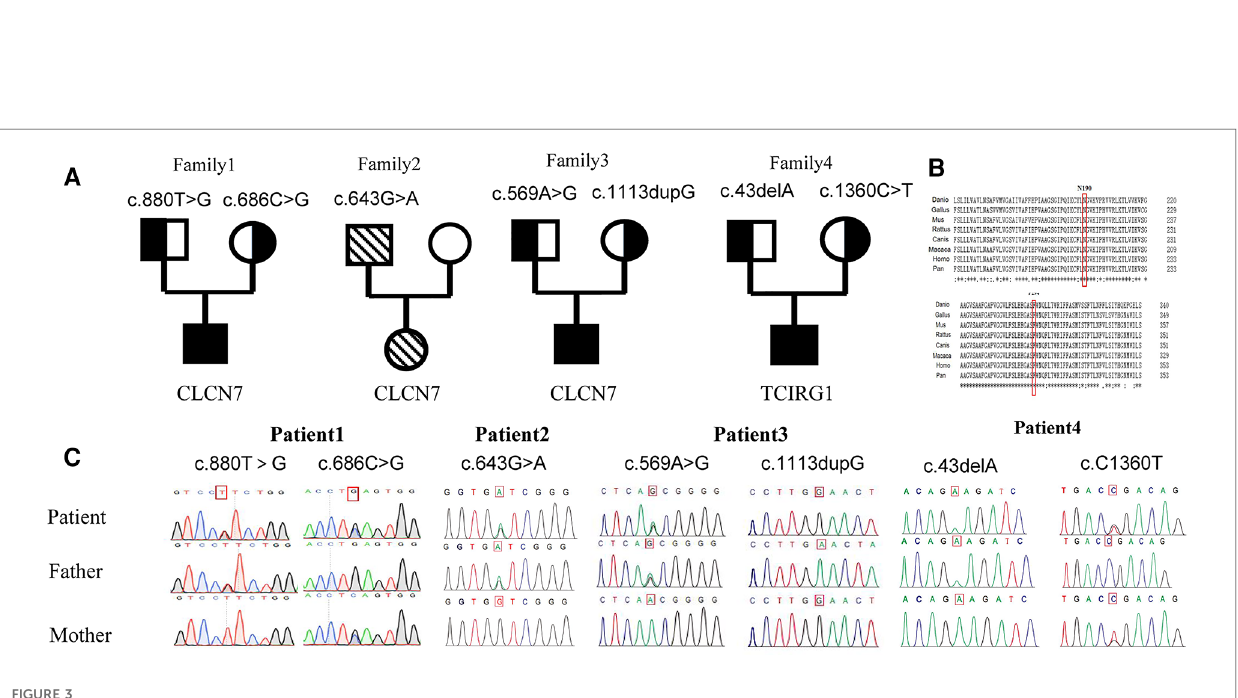
FIGURE 3 Family pedigrees and genetic sequencings. ( A ) Pedigree for each patient. ( B ) Genetic analysis of the gene mutation in family of Patient 1: compound heterozygous variants c. 880T>C( p . F294V) and c. 686C>G( p . S229X) in the CLCN7 gene. Homologous sequences of CLCN7 across species ( C ). A cross-species alignment of amino acid sequences showed that p . F294V and p . N190S variants occur in a highly conserved